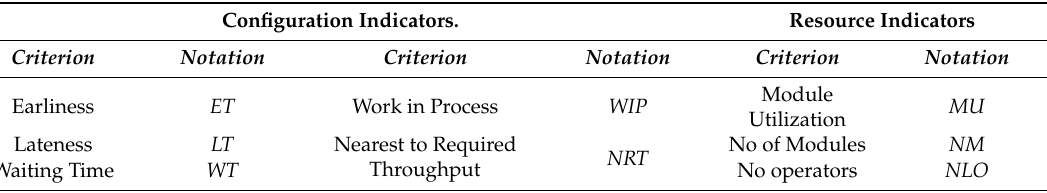
Table 1. Operational criteria.